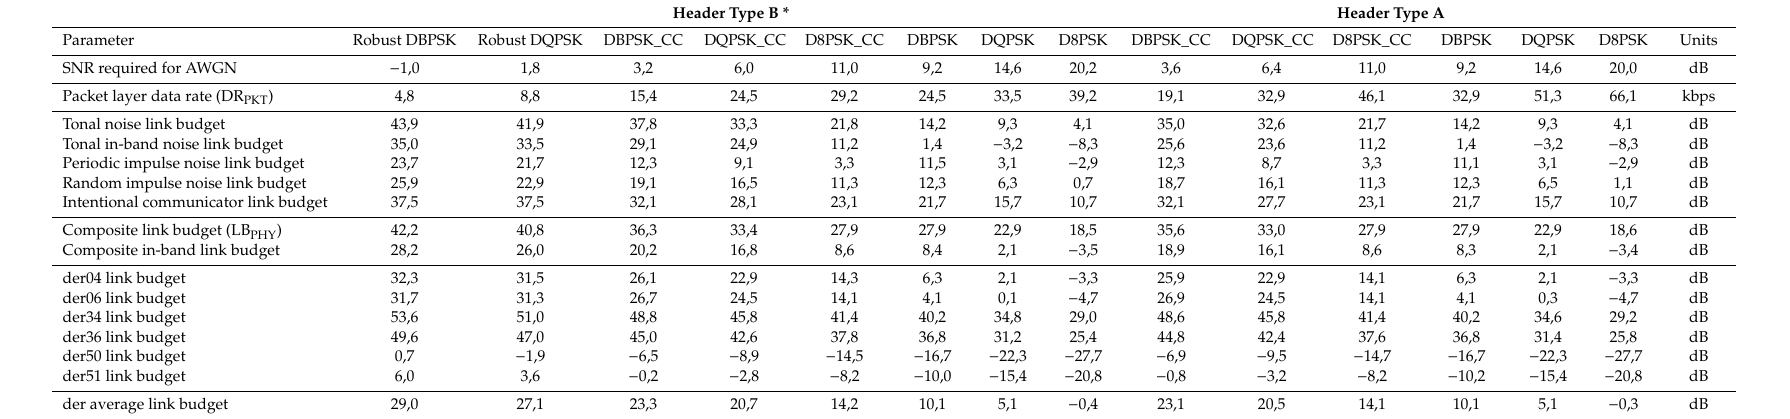
Table 4. Absolute results with the spline equalizer for PRIME 1.3.6 and 1.4.